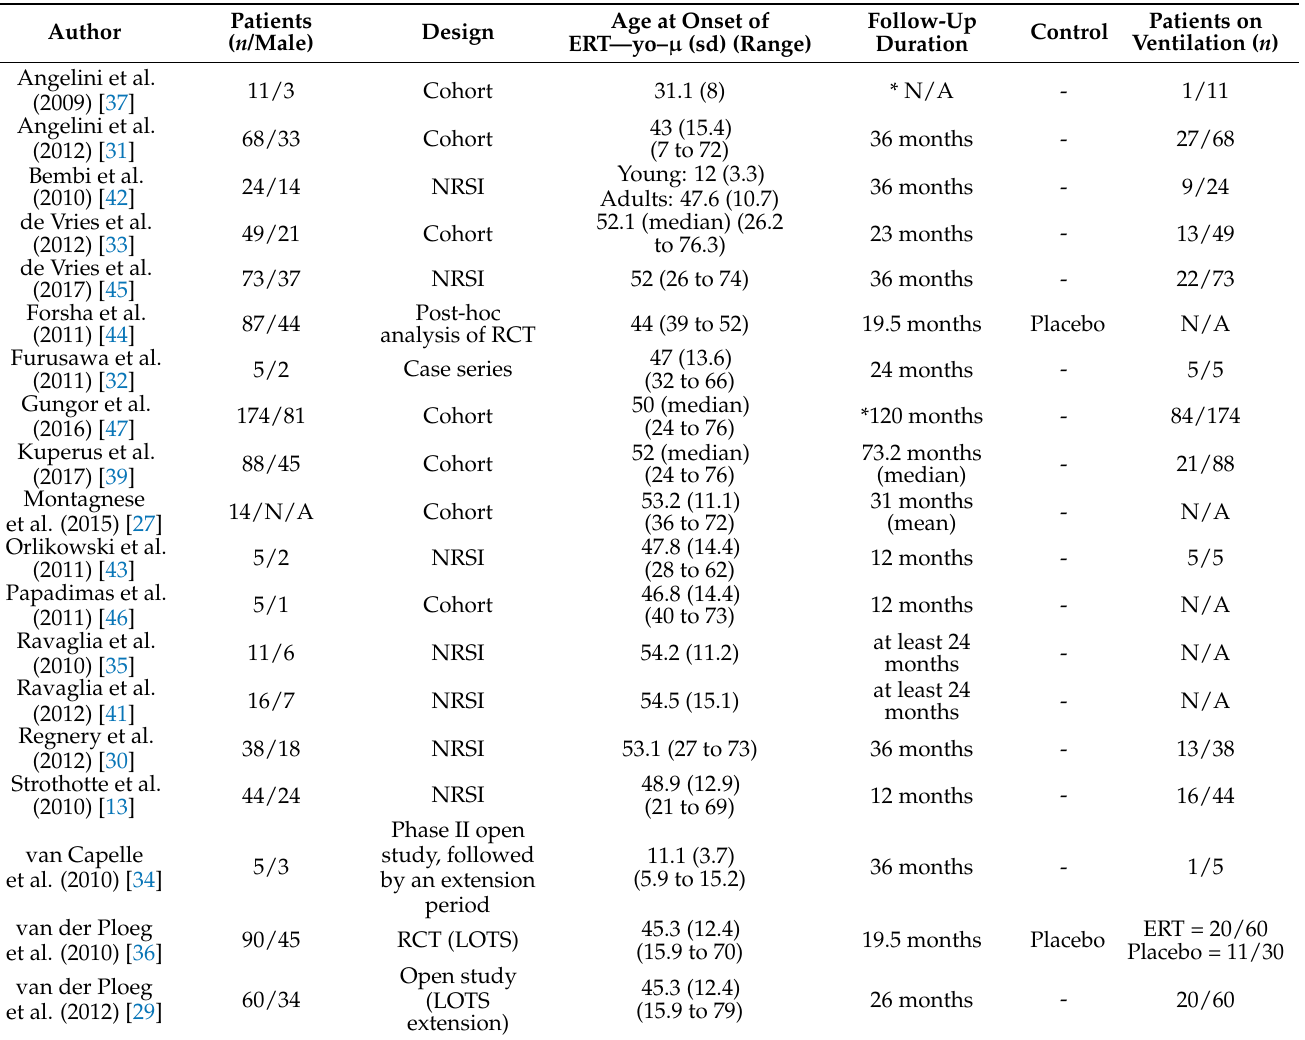
Table 3. Included studies and their